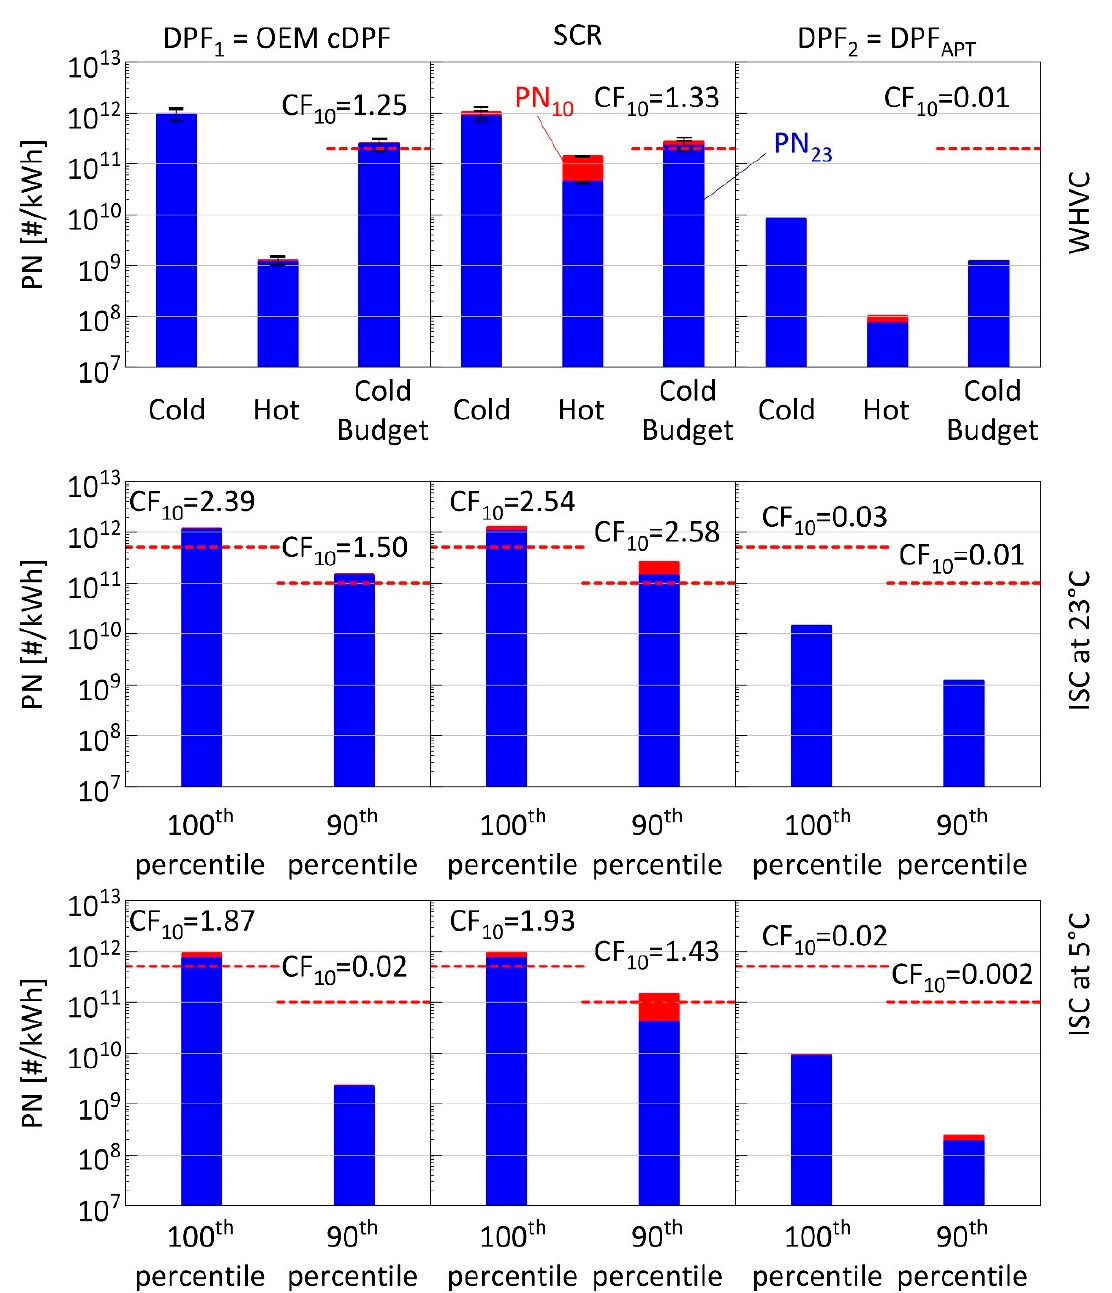
Figure 4. Summary of Particle Number (PN) emissions following what has been proposed as post Euro VI evaluation methodology, for the tests where the OEM cDPF was used. Charts on the left, middle and right planes correspond to emission levels at DPF 1 out, SCR and DPF 2 out positions, respectively. Charts on the top, middle and bottom planes correspond to WHVC, ISC at 23 ◦ C and ISC at 5 ◦ C tests, respectively. Blue bars correspond to SPN 23 while red bars correspond to SPN 10 . The error-bars indicate the maximum and minimum emissions, while the dashed lines indicate the proposed limits (2 × 10 11 #/kWh for budget, 5 × 10 11 #/kWh for 100th percentile, and 1 × 10 11 #/kWh for 90th percentile), while the numbers on top represent the conformity factor (ratio of average emissions over applicable limit). APT = Accelerated Purification Technology; cDPF = Catalyzed DPF; CF = Conformity Factor; DPF = Diesel Particulate Filter; ISC = In-Service Conformity Cycle; OEM = Original Equipment Manufacturer; SCR = Selective Catalytic Reduction; WHVC = Worldwide Harmonized Vehicle